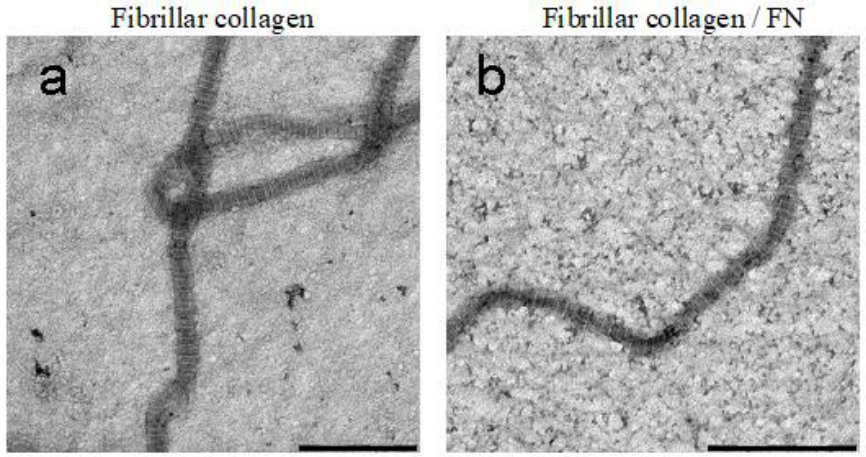
Figure 2. TEM images of fibrillar collagen with/without fibronectin: a — fibrillar collagen; b — fibrillar collagen + fibronectin. Scale bar 500 nm.